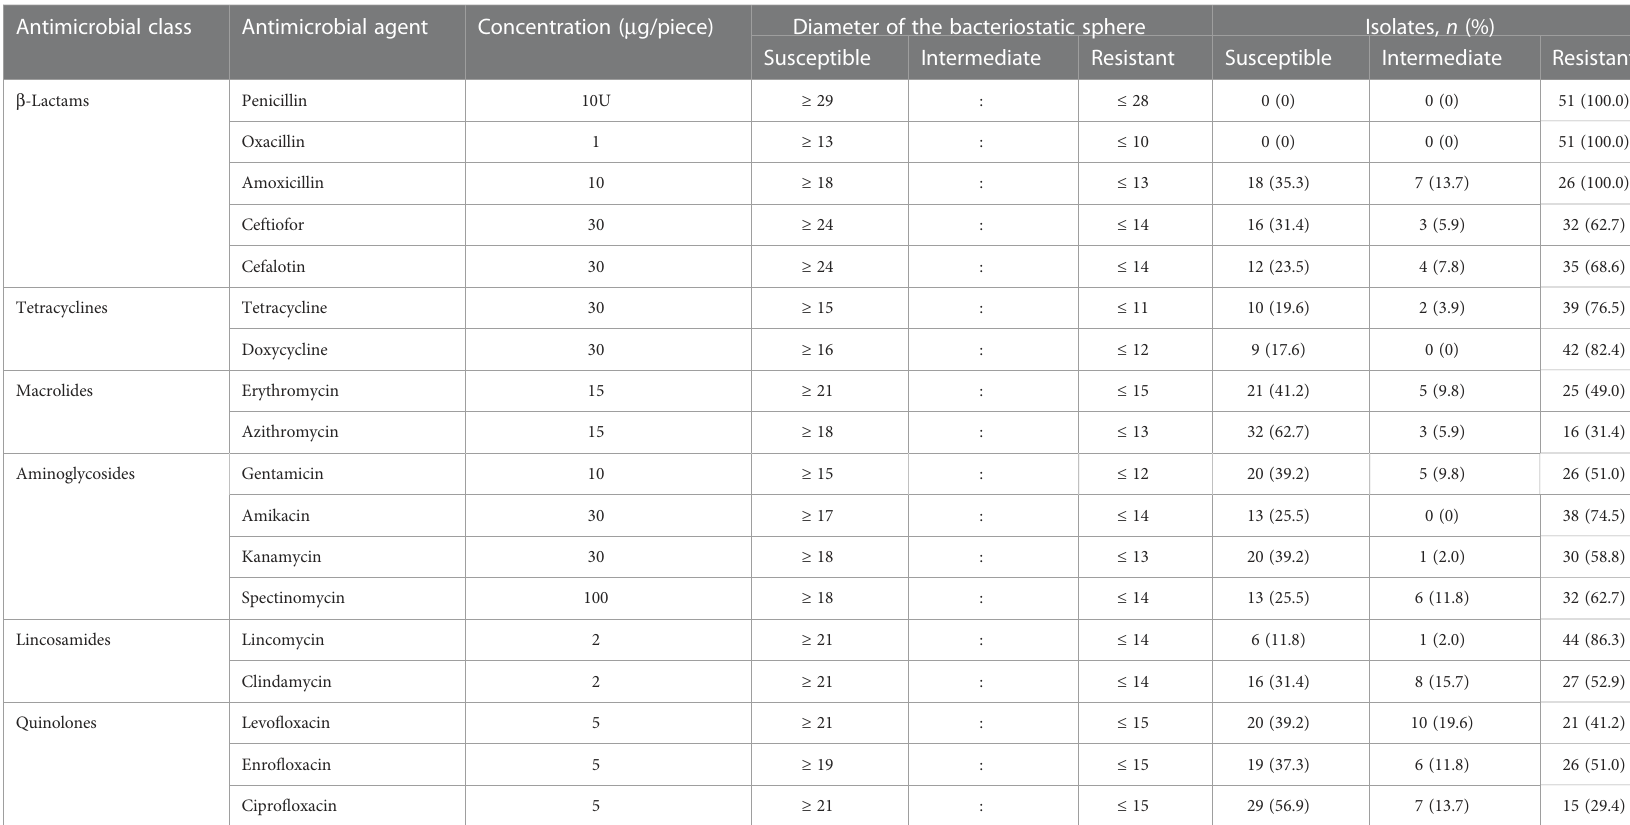
TABLE 4 The antimicrobials disk breakpoints and the distributions of antimicrobial resistance of 51 S. agalactiae strains isolated from milk samples of goats with clinical mastitis. Antimicrobial